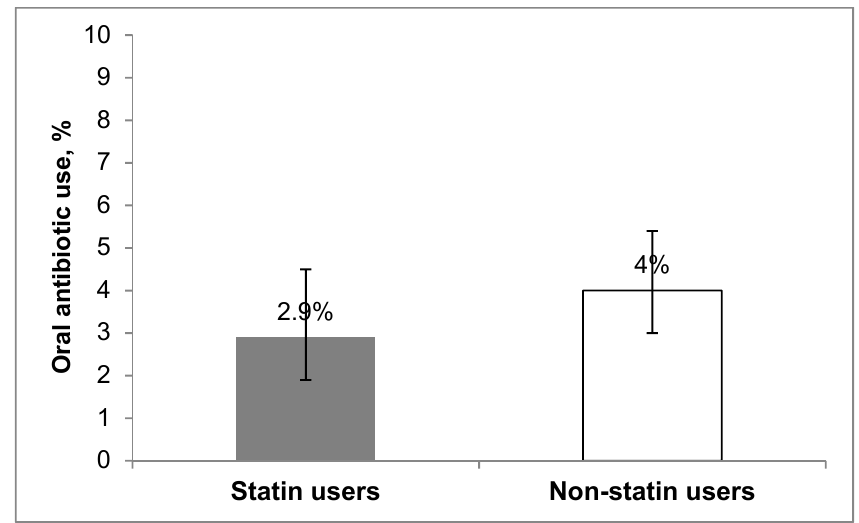
Figure 1. Oral antibiotic use in patients with diabetes according to statin use ( p = 0.259 for unadjusted model, p = 0.116 for adjusted model) .